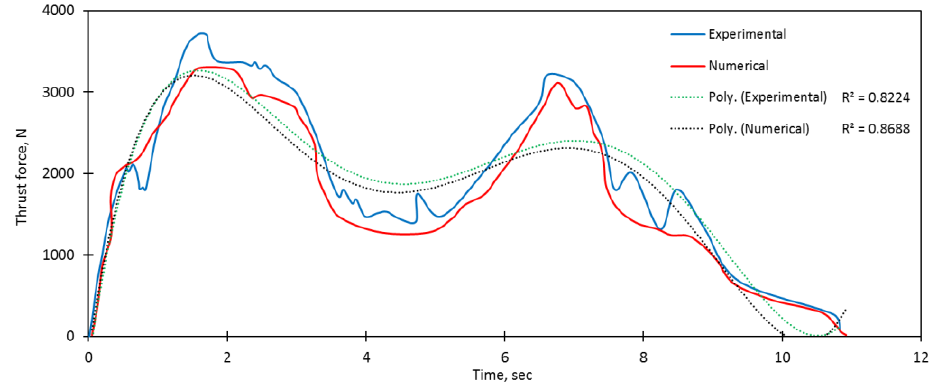
Figure 22. Prediction and comparison of required thrust force for experimental work and numerical